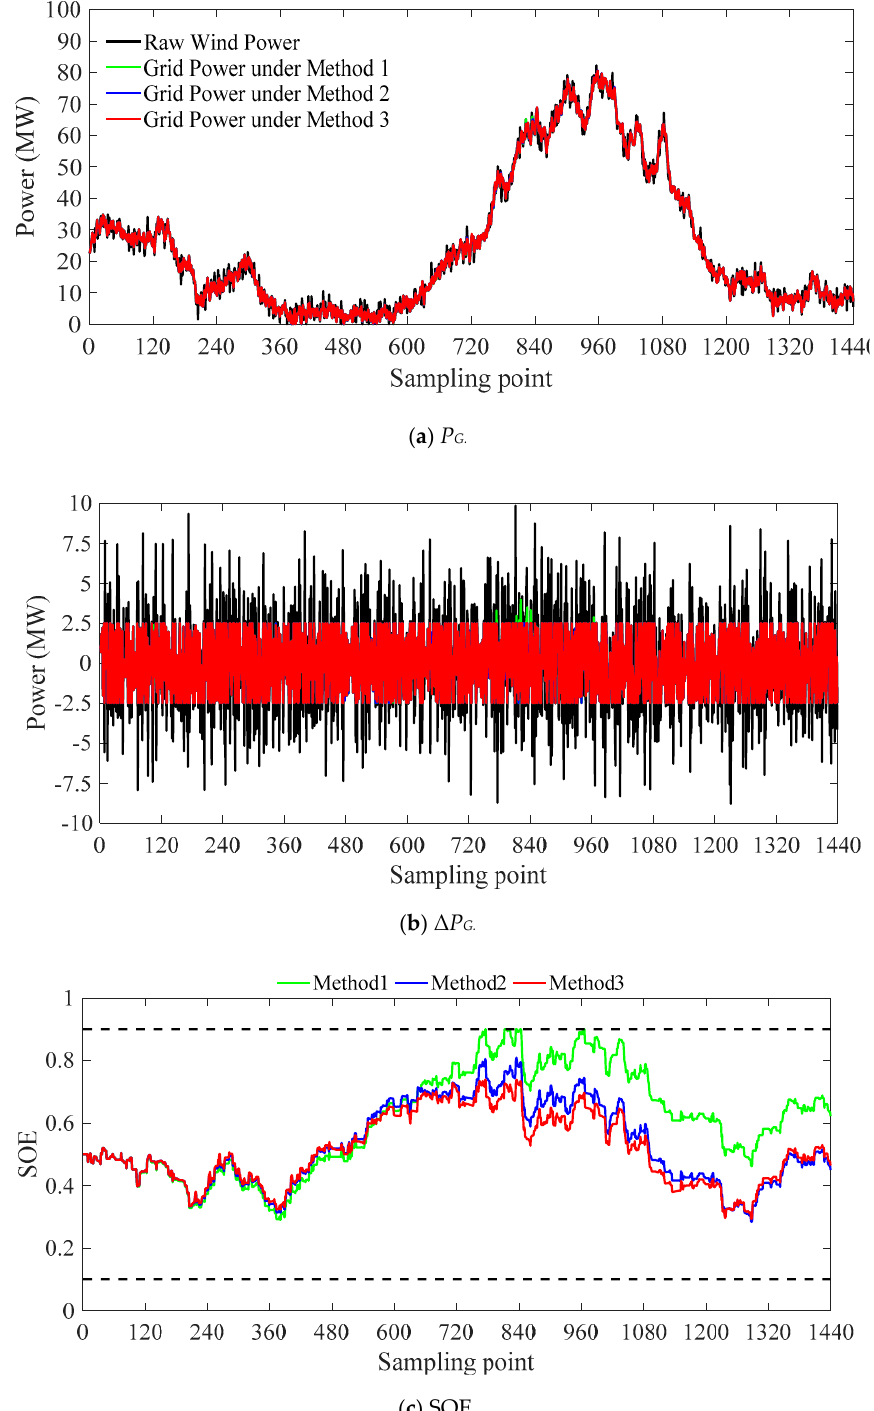
Figure 12. Curve of grid-connected power, grid-connected power fluctuation and SOE of BESS with different methods. ( a ) P G , ( b ) ∆ P G , and ( c ) SOE under Q = 2 MW, δ = 2.5 different methods. ( a ) P G , ( b ) Δ P G , and ( c ) SOE under Q = 2 MW, δ = 2.5 MW.